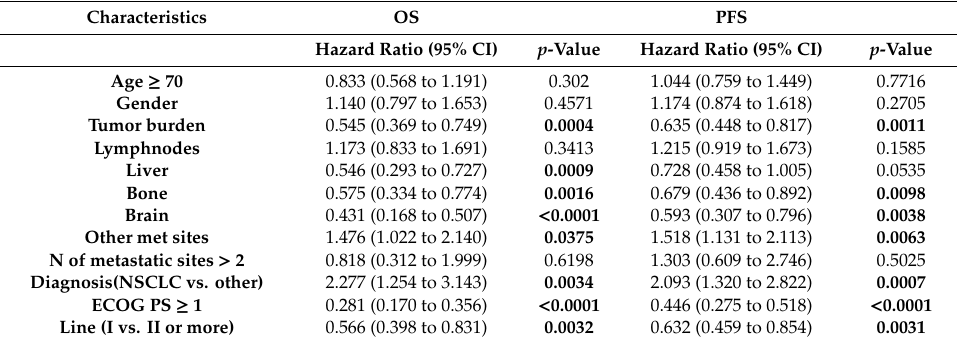
Table 3. Univariate analysis for overall survival and progression free